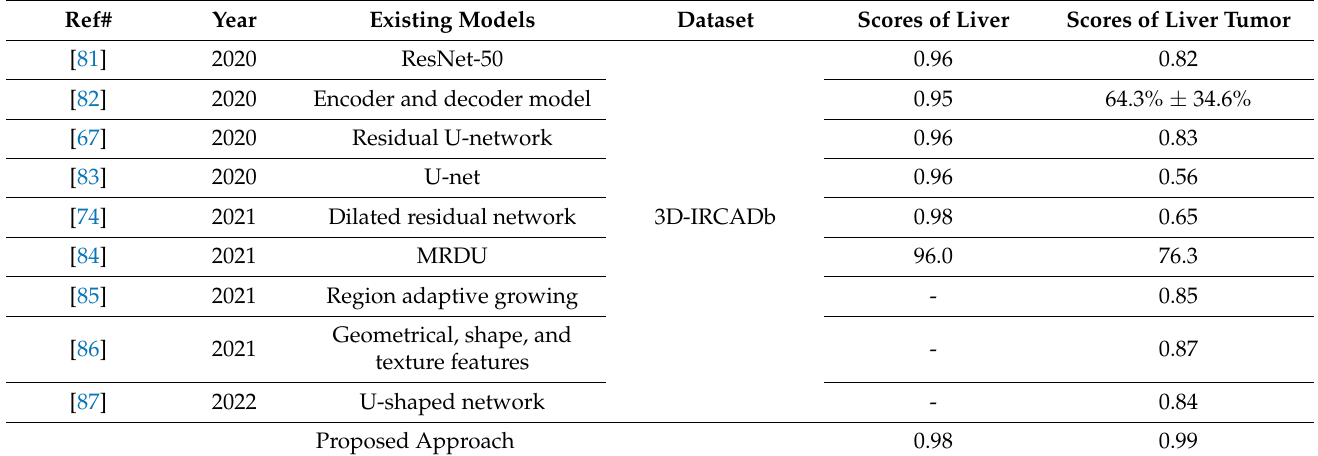
Table 8. Recent existing work